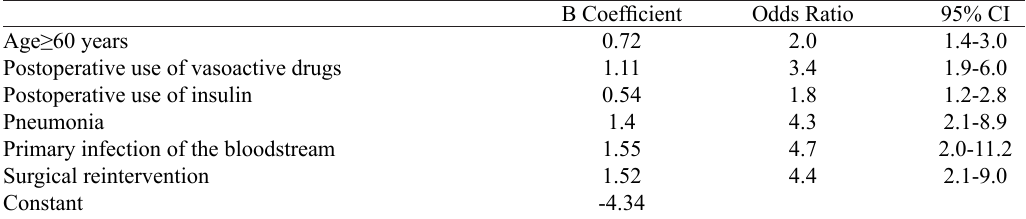
Table 8. Variables associated with evolution in the logistic regression